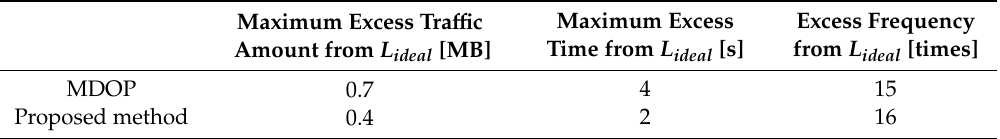
Table 7. Details of temporal